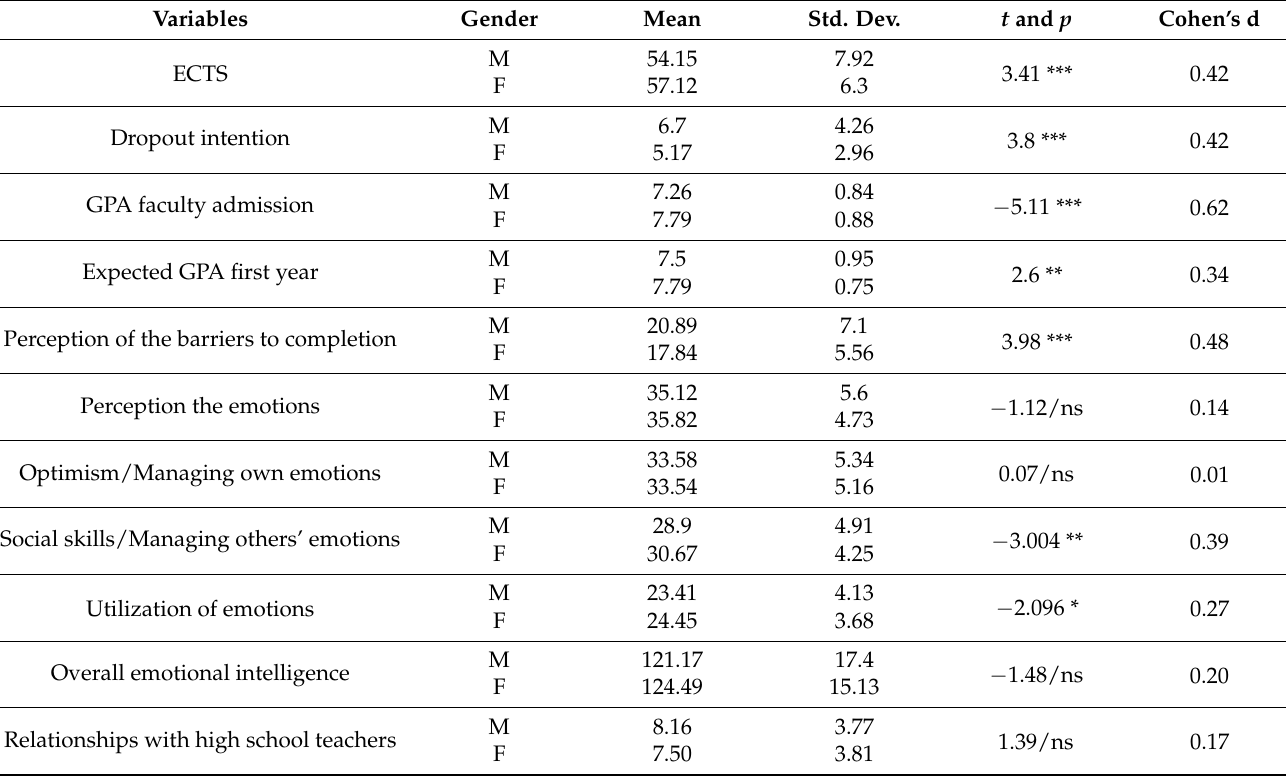
Table 2. Gender differences